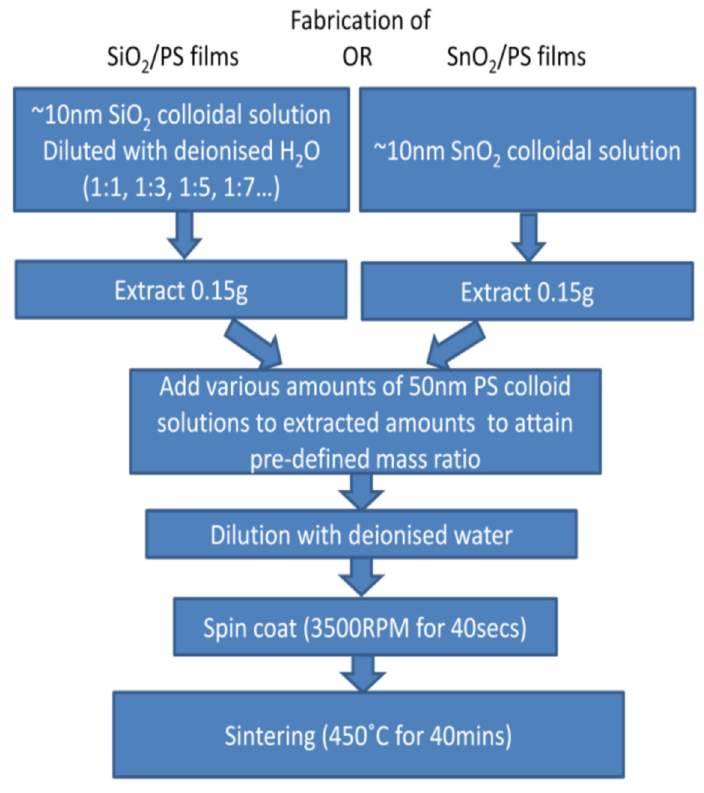
Figure A2. The process for making SnO 2 particle or SiO 2 particle Figure B1. The process for making SnO 2 particle or SiO 2 particle films.